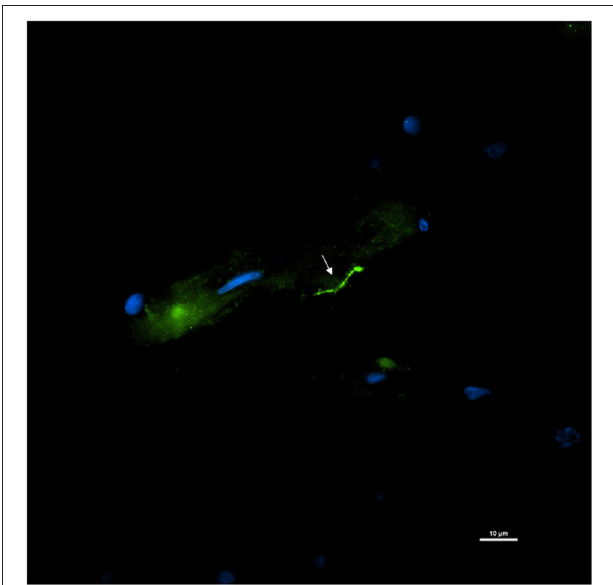
FIGURE 12 | Detection of an intact Borrelia spirochete in a fixed autopsy tissue using Immunofluorescence assay. 12,577-spinal cord autopsy tissue was immunostained with rabbit B. burgdorferi hyperimmunized polyclonal (primary) and goat anti-rabbit IgG Alexa Fluor 488 (secondary) antibodies. White arrow points toward a green fluorescence of morphologically intact spirochete. Scale bar − 10 µ m. Image was acquired with a Nikon fluorescence microscope using a 40x